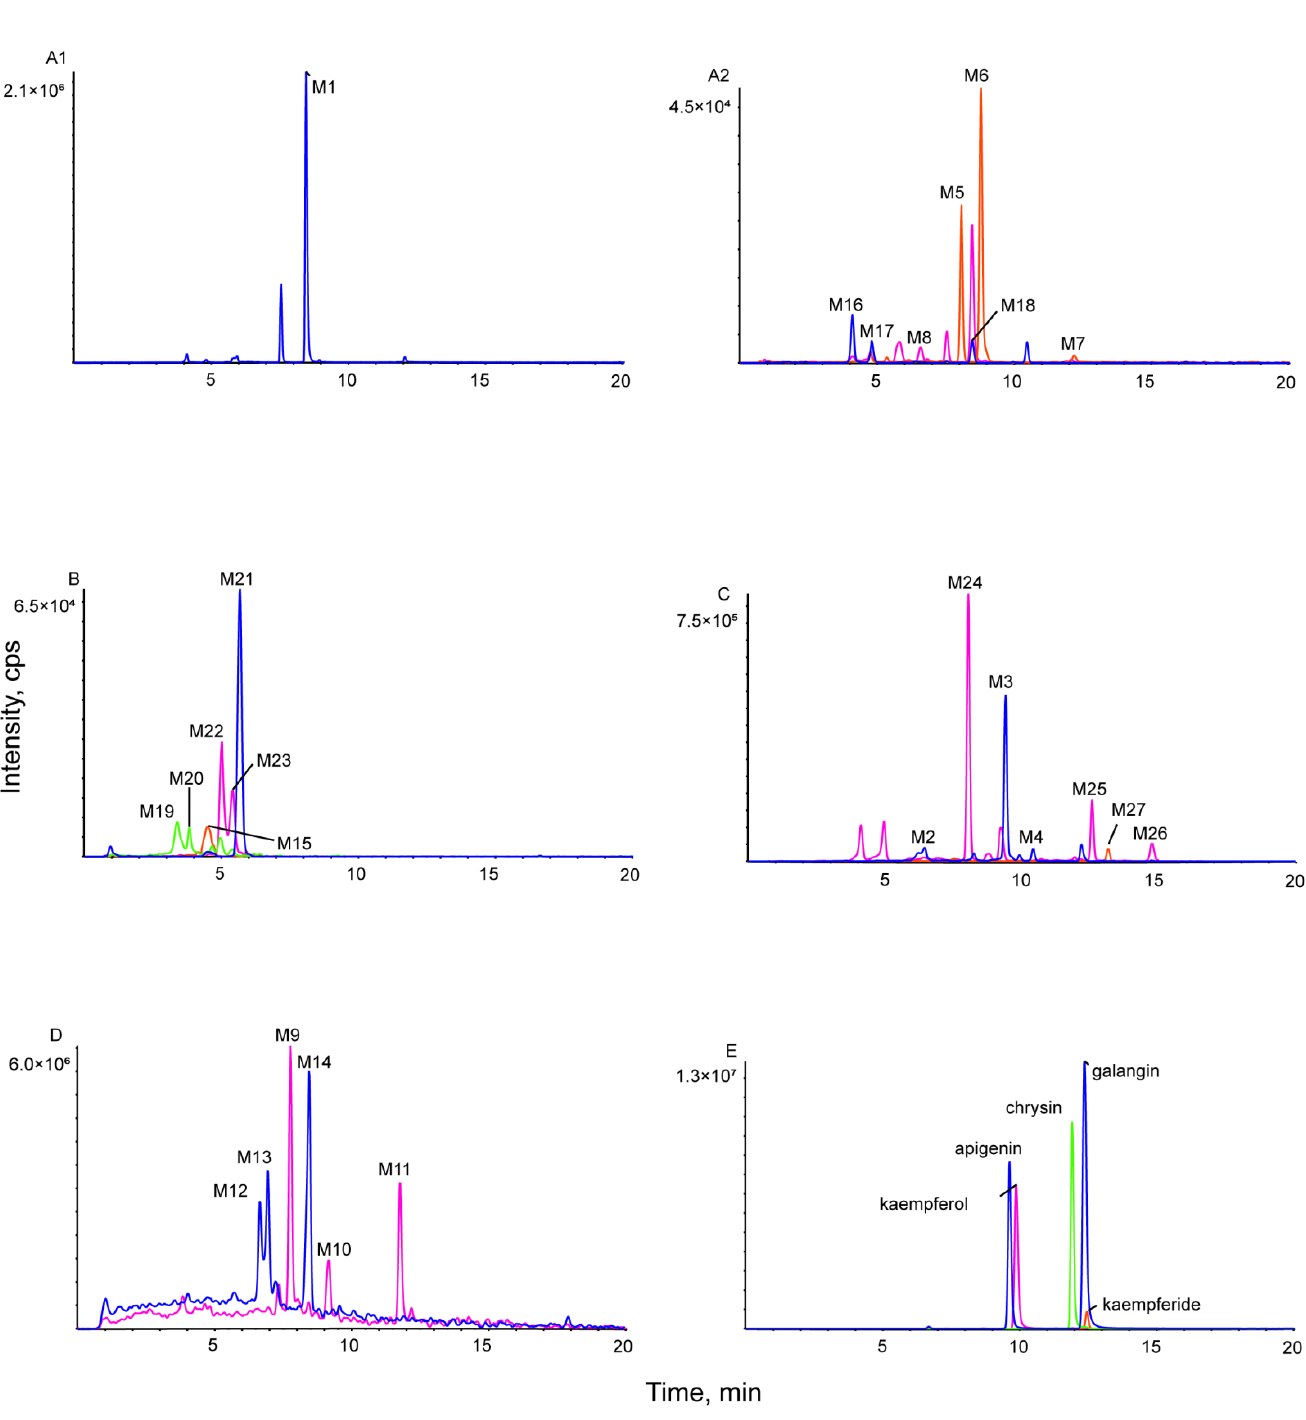
Figure 6. Extracted ion chromatograms of all metabolites of galangin in vitro and in vivo ( A1 , A2 ) in rat blood sample, ( B ) in rat bile sample, ( C ) in rat urine sample, ( D ) in rat fecal sample, and ( E ) in mixed standard solution.